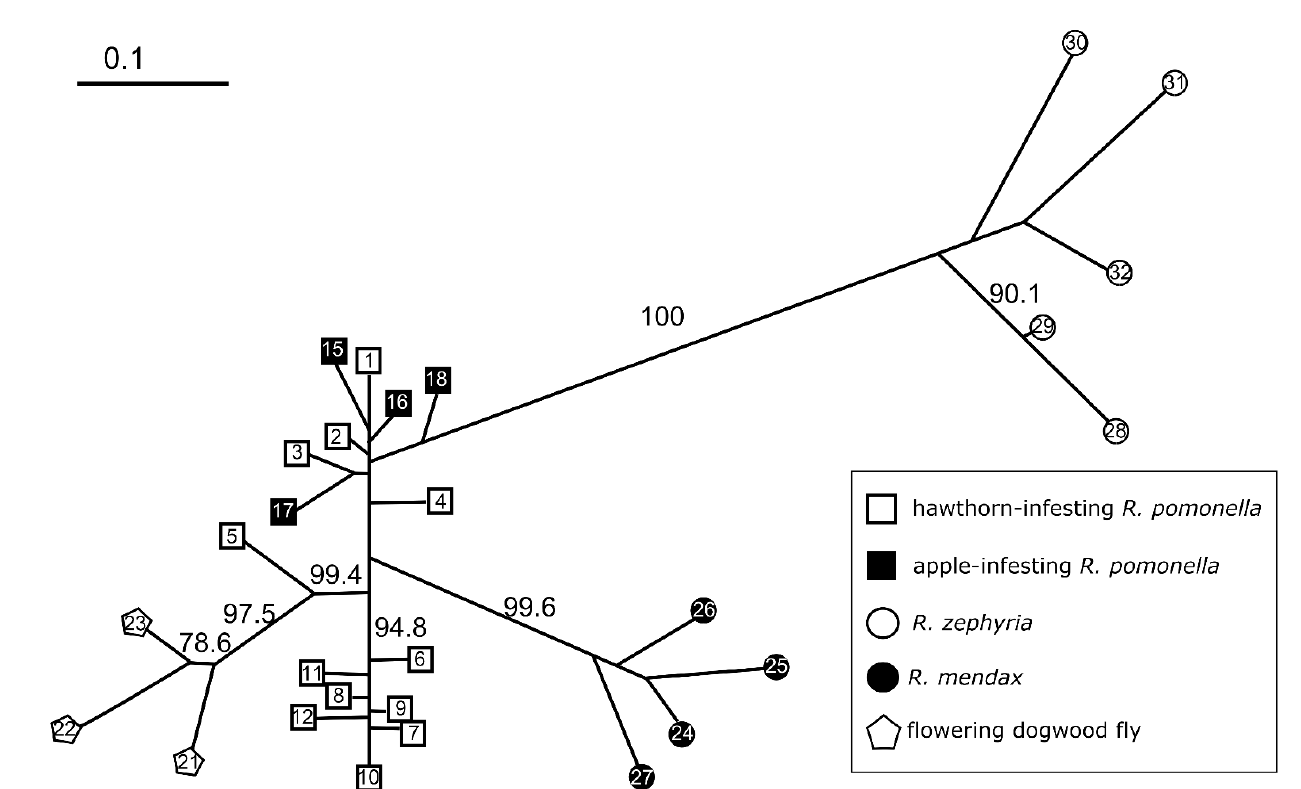
Figure 2. Neighbor-joining network based on Nei’s D (1972) estimated from microsatellite allele frequencies for 19 loci for 32 populations of in-group RPSG taxa. Open squares = hawthorn-infesting R. pomonella ; closed squares = apple-infesting R. pomonella ; open circles = snowberry-infesting R. zephyria ; closed circles = blueberry-infesting R. mendax ; pentagons = flowering dogwood fly. R. cornivora is omitted from this network due to poorly supported positioning and a branch length that obscures the primary features of the in-group network. The full network, including R. cornivora , is presented in Figure S4. Bootstrap values come from 10,000 replicates across loci. Numbers within nodes refer to sites listed in Table 1.